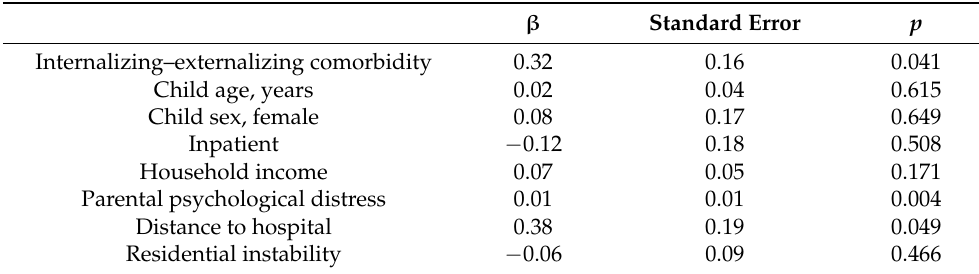
Table 2. Linear regression modeling assesses the association between internalizing–externalizing comorbidity and